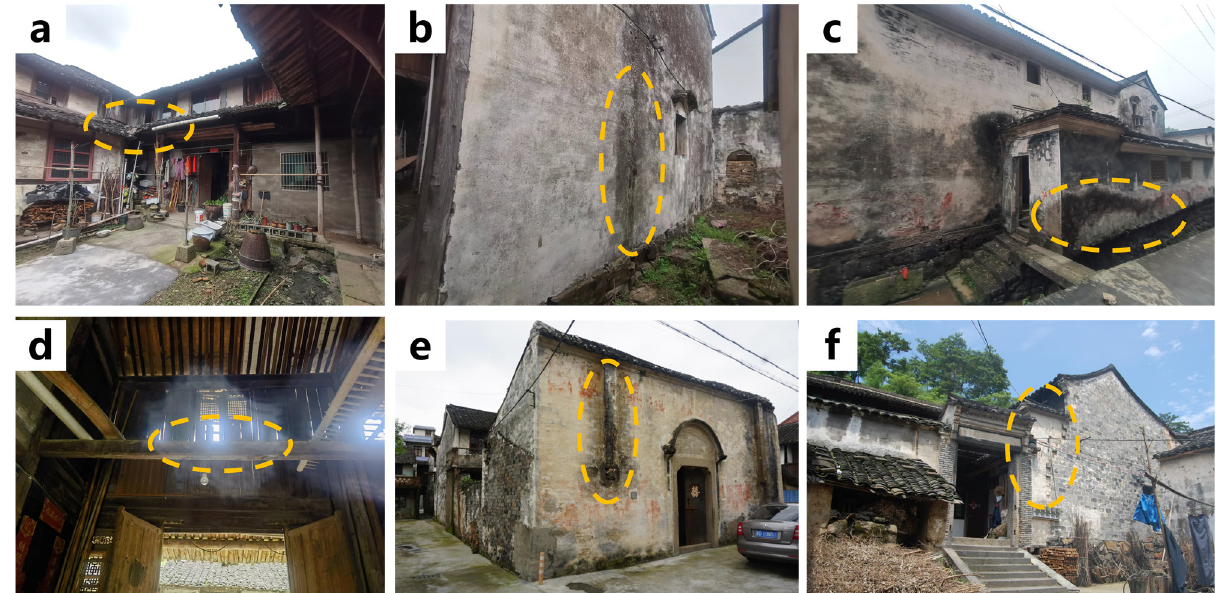
Figure 1. Buildings: ( a – c ) Shaoxing City Keqiao District LiZhu town residential; ( d – f ) Shaoxing City Keqiao District Hutang street residential. Yellow circles present deterioration areas.